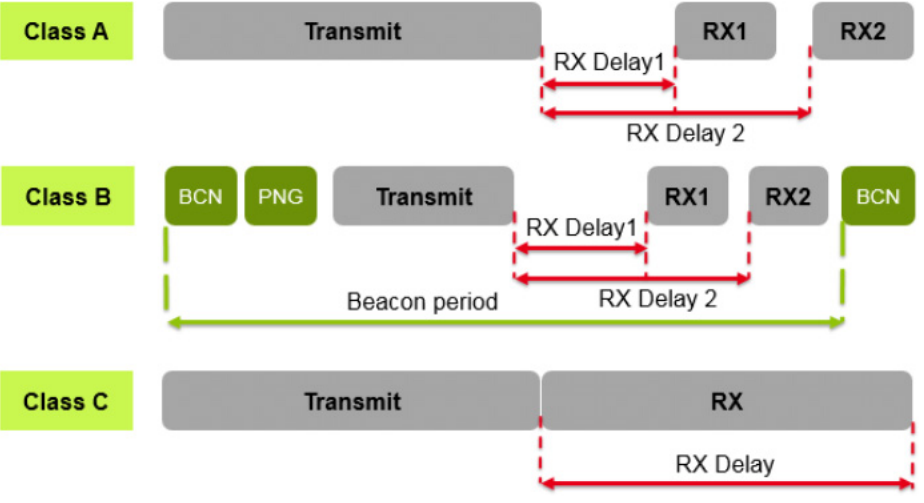
Figure 2. Uplink and downlink methodology in Class A, B and C.